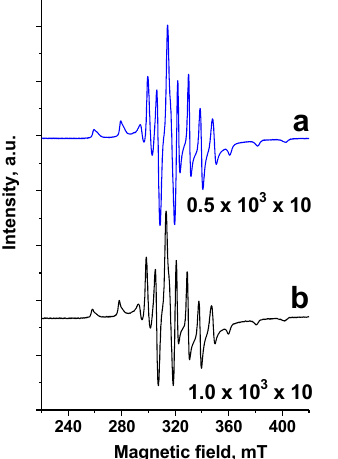
Figure 4. ESR spectra of ( a ) V M /SBA-15 and ( b ) TPS/V M /SBA-15. For further characterization of vanadium species, XPS analyses were performed. This method, as well as the elemental analysis, was used to exclude the presence of TPS species in the samples after interaction with vanadium species. For both TPS/V M /SBA-15 and TPS/V S /SBA-15 samples, no bands related to the presence of sulfur were identified. The data from elemental analysis also indicated the lack of sulfur in the final material. Thus, one can conclude that there were no TPS species remaining in the samples after the interaction of vanadium-containing materials with